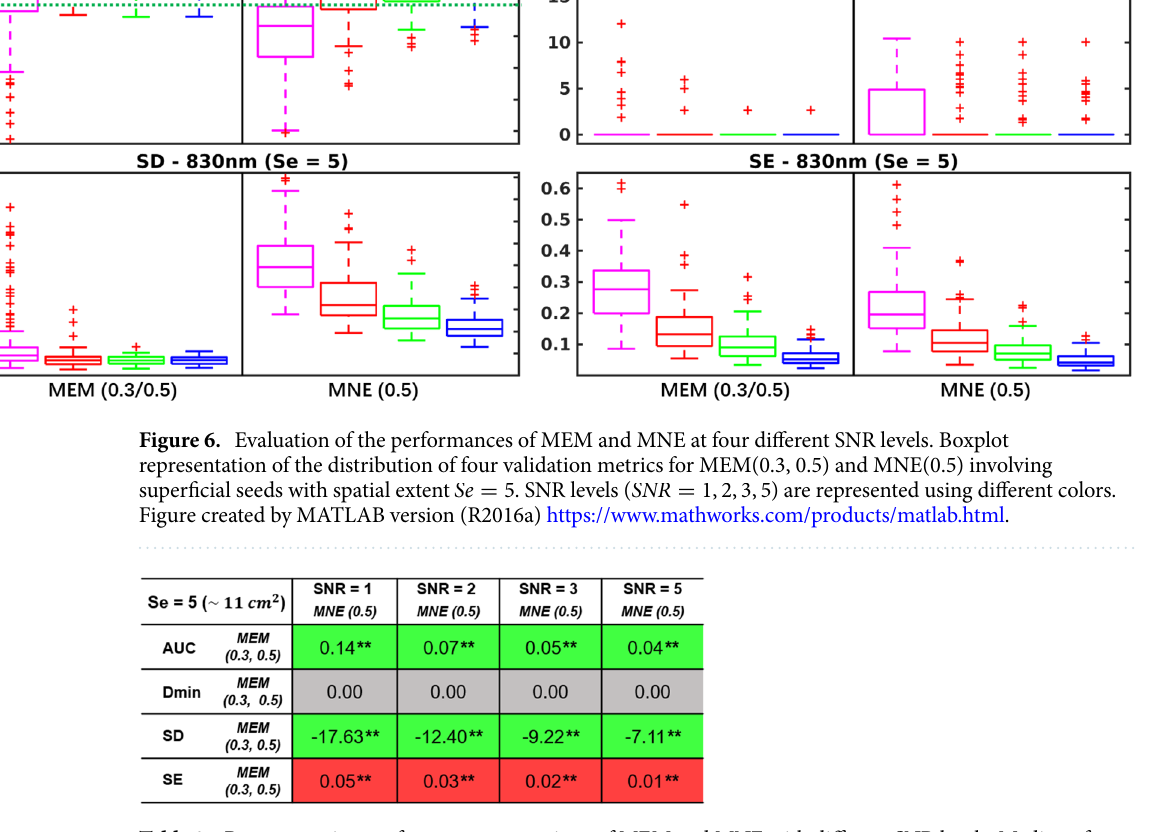
Table 2. Reconstruction performance comparison of MEM and MNE with different SNR levels. Median of paired difference of validation metric (i.e. AUC, Dmin, SD and SE) values of Se = 5 are presented in the table following the SNR increase from 1 to 5. ** indicates corrected p < 0.001